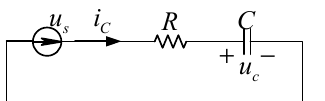
Figure 7. L/C switch equivalent circuit when valve 1 is turned off. ( u s : Voltage of VT1) u in a switching cycle can be listed in Table 2. Similarly, when VT1 is turned off, s